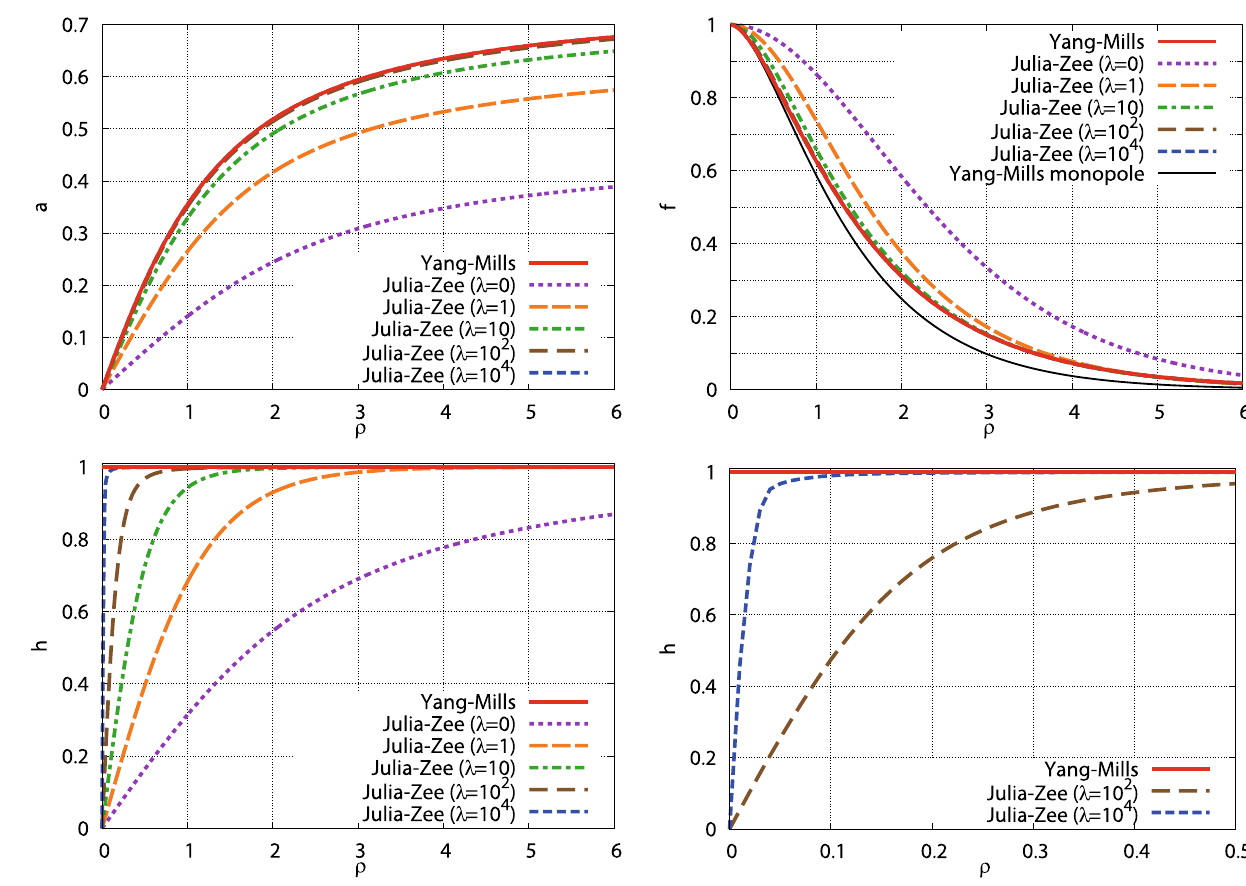
Fig. 1 (Top) The solutions a (left panel) and f (right panel) of the Yang–Mills dyon Eqs. (59) and (60) as functions of ρ = g v r , which are to be compared with the Yang–Mills monopole and the Julia–Zee dyon solutions for λ = 0 , 1 , 10 , 10 2 , and 10 4 for C = 0 . 5. (Bottom) The corresponding solution h for the scalar field as a function of ρ . The